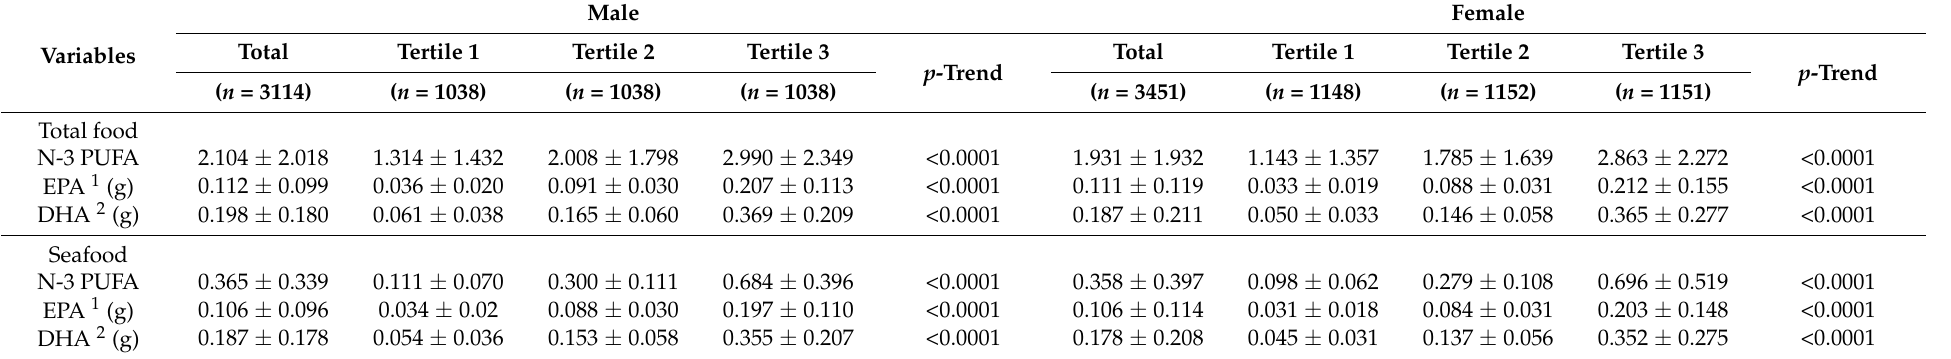
Table 3. EPA and DHA intakes of participants according to seafood-intake